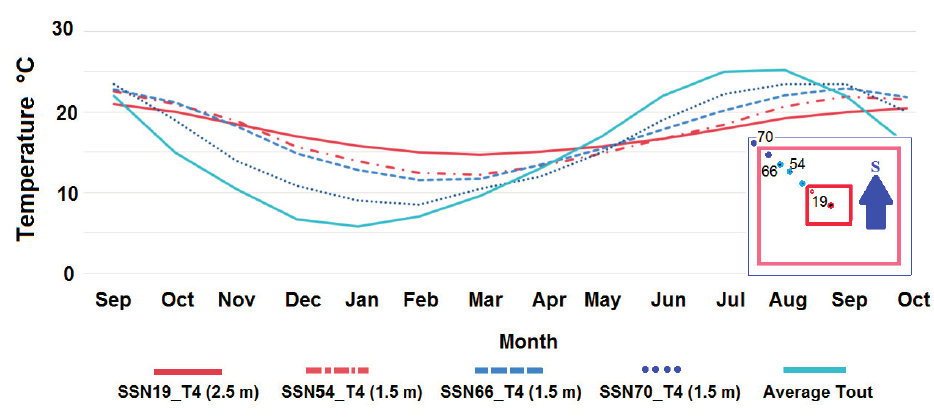
Figure 21. Underground soil temperature along a year.